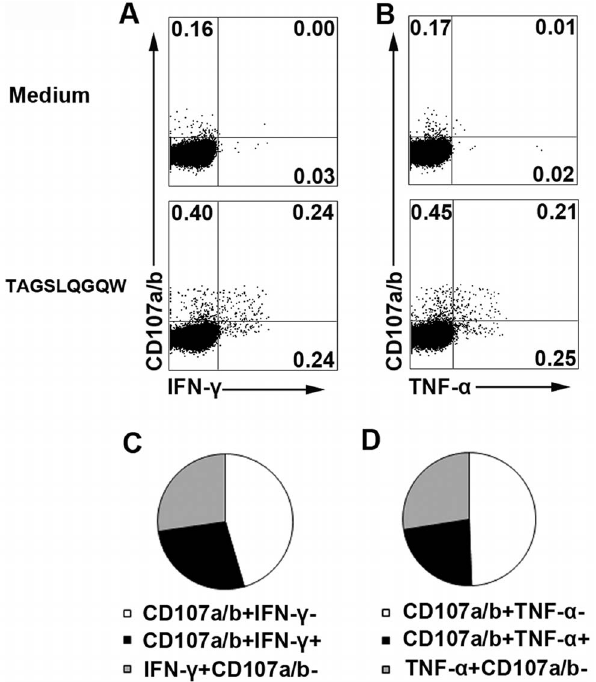
Figure 8. Coexpression of CD107a/b and IFN- c or TNF- a in CD8 + T cells following stimulation with 9aa CFP10 peptide. PFCs were stimulated with or without TAGSLQGQW (CFP10 35–43 ) in the presence of anti-CD107a/b mAbs for 8 h. (A, B) The expression of CD107a/b, IFN- c (A) and TNF- a (B) by CD8 + T cells was assessed by flow cytometry. Numbers in quadrants indicate percentages of the cells in each population. (C, D) Coexpression of CD107a/b and IFN- c (C) or TNF- a (D) by CD8 + T cells was shown. The data were quantified and presented in a pie chart, in which each slice of the pie represents the fraction of the median frequencies of a given quadrant. Data shown are representative of three independent experiments with similar results.